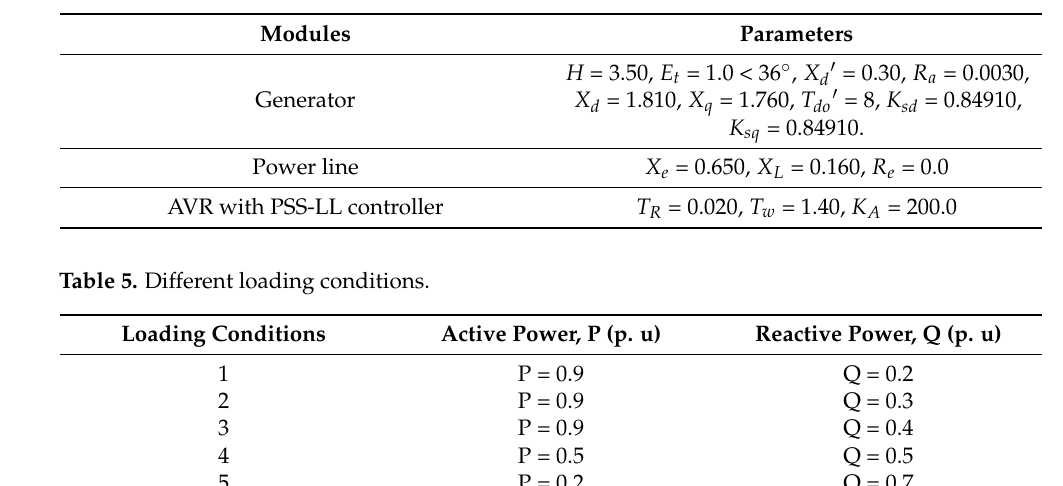
Table 4. Parameters for the SMIB and PSS.